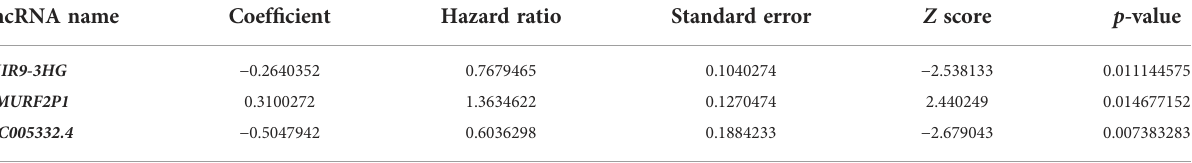
TABLE 2 The results of lncRNAs involving TCGA-CESC data after the multivariate Cox regression.